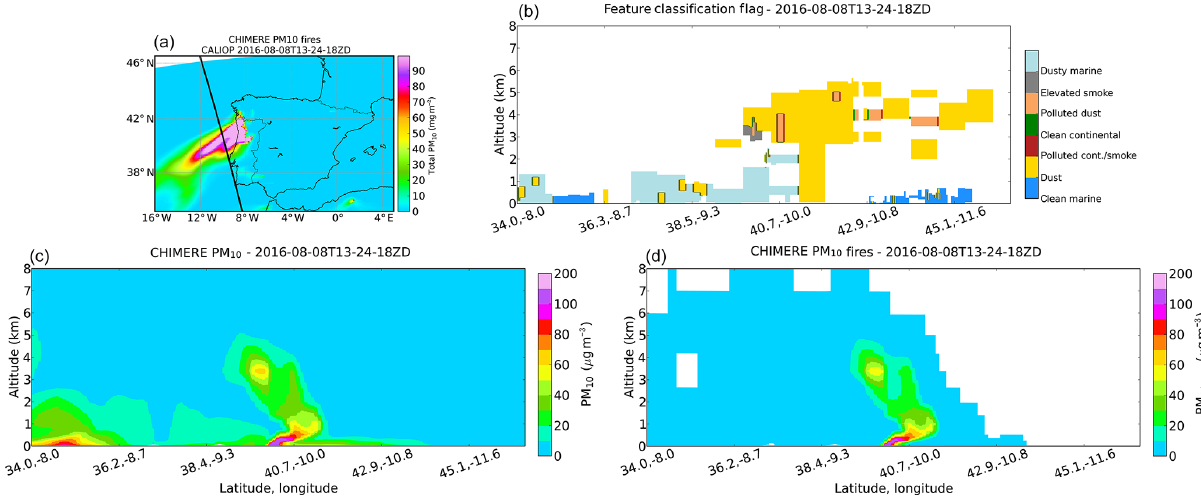
Figure 17. Same as Fig. 16 but for the daytime